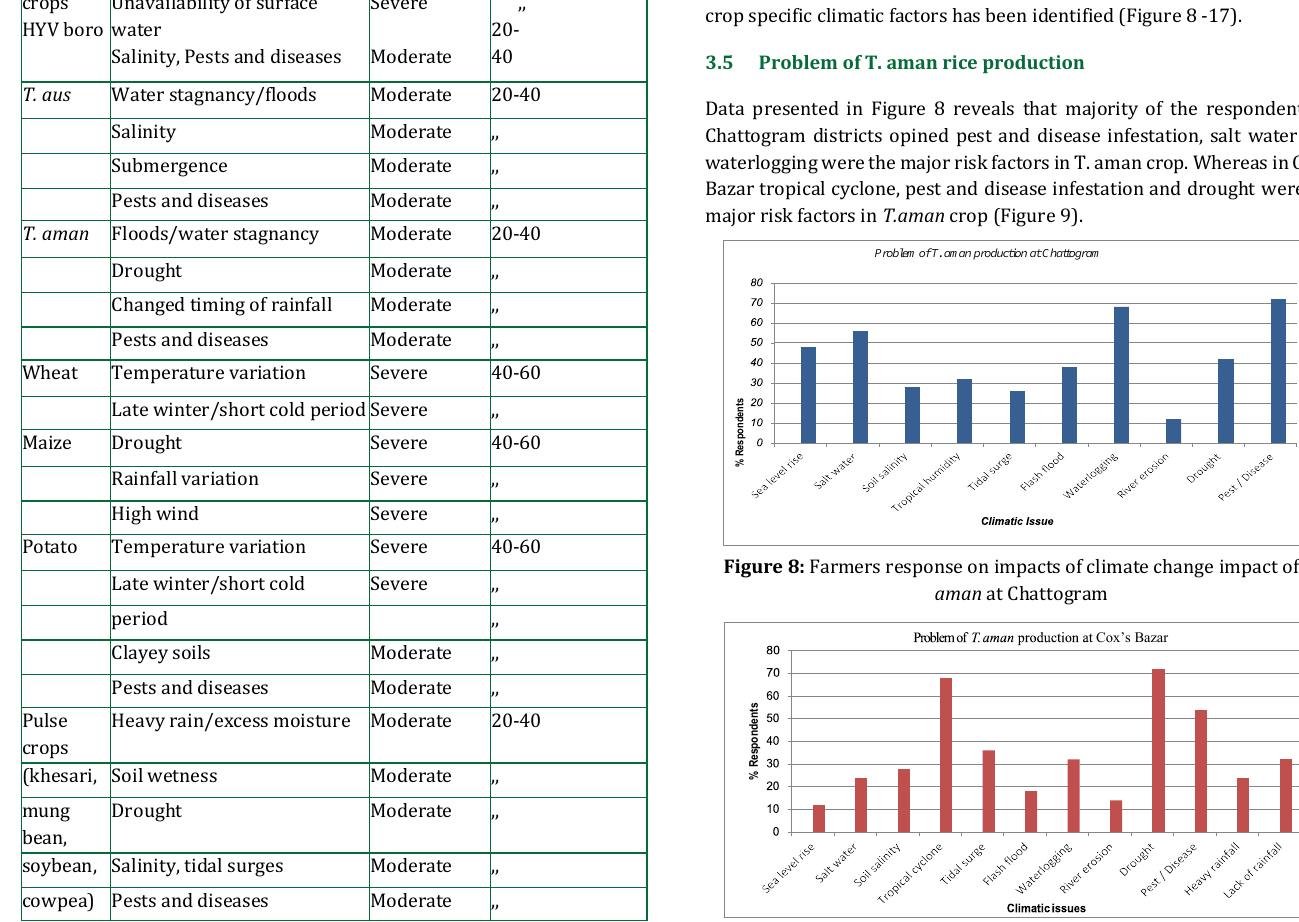
Figure 9: Farmers response on impacts of climate change affecting